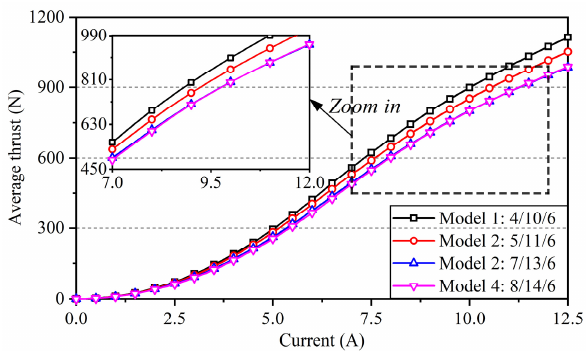
Figure 15. The average thrust performance under different currents.